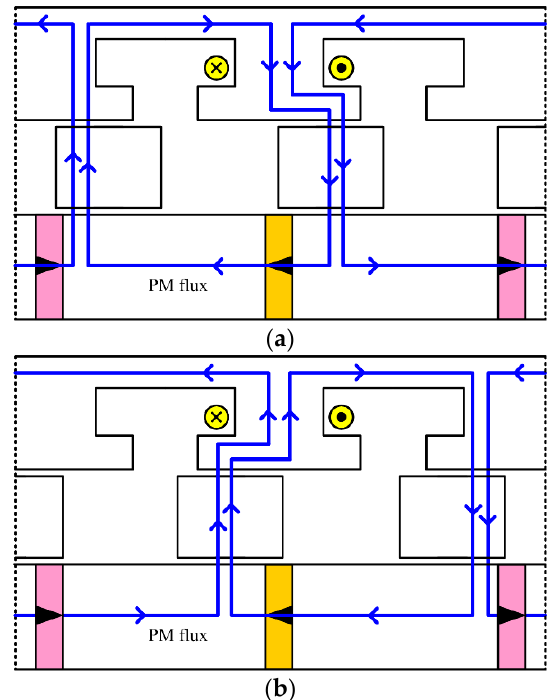
Figure 2. Field paths of PS-SFPM machine, ( a ) Rotor on right hand side; ( b ) rotor on left hand side. Figures are modified with permission from [19], published by IEEE, 2017.